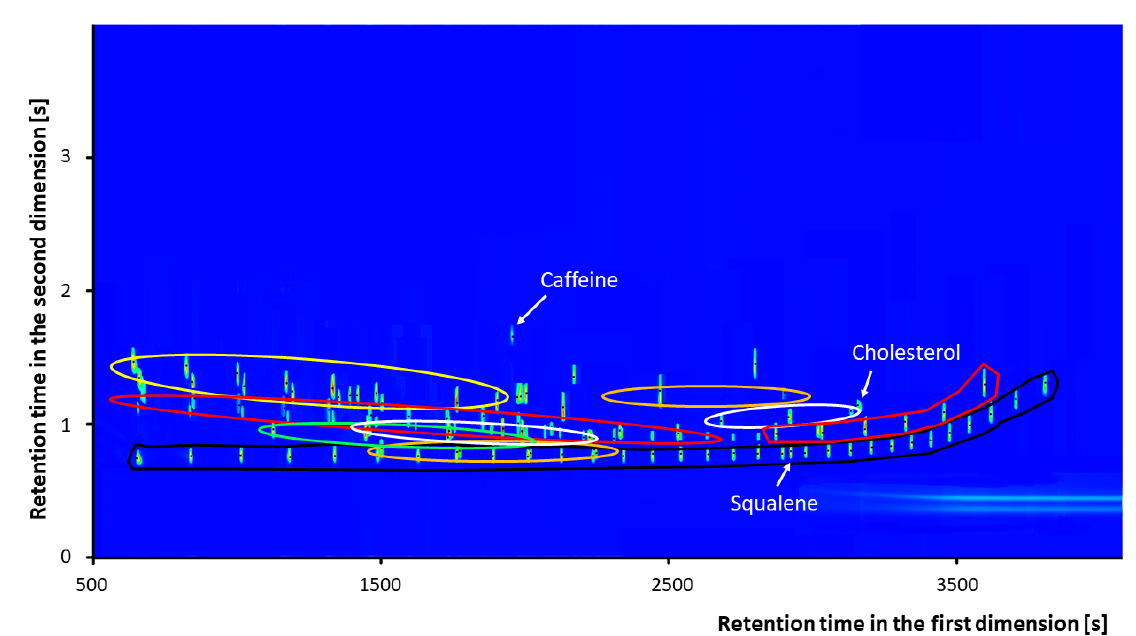
Figure 4. The TIC 2D chromatogram of the model mixture (composition see Table 1) measured under the conditions described in Section 2.4 on Rxi-5ms (2 + 30 m) and Rxi-200MS (1 m) columns. The marked classification zones are the following: black ( n -alkanes), lower dark yellow (amines), upper dark yellow (amides), green (chloroalkanes), left white (alcohols), right white (ethers), yellow (aldehydes and ketones), left red (acids and esters), right red (esters of higher fatty acids), and unlabeled (others).